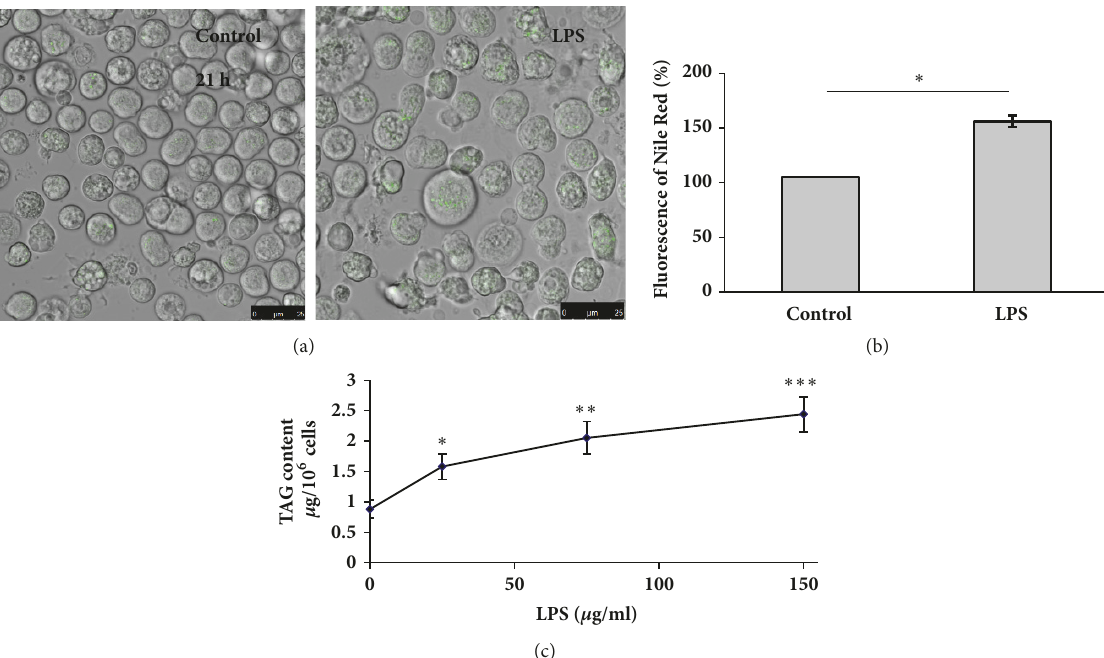
Figure1:LPSstimulateslipiddropletbiogenesis (a,b) andintracellularaccumulationofTAG (c) . (a,b) FUBECincubatedwithLPS(25 𝜇 g/ml) orwithoutitfor21hwerestainedwithNileRedfor10min.Thesuspensionwasthentransferredtotheconfocalcamera,andmicrophotographs were obtained with a Leica TCS SP5 MP microscope ( 𝜆 ex = 488 nm, 𝜆 ex = 510 – 560 nm, dry objective x40). ∗ p < 0.05 (n=4). (c) Dose dependency of LPS effect on the intracellular TAG content. Cells were incubated with or without LPS for 21 h, harvested, and subjected to lipid extraction and TLC. n=6 independent experiments. ∗ p < 0.05; ∗∗ p < 0.01; ∗∗∗ p < 0.001 versus control (the zero point on the